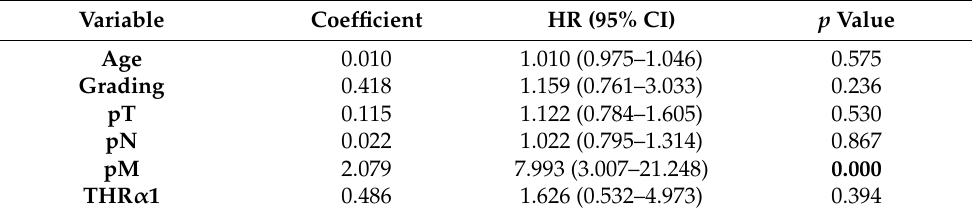
Figure 2. Kaplan–Meier survival analysis among thyroid hormone receptor α 1 (THR α 1) positive and negative patients. DFS of patients with unifocal BC. Table 2. Multivariate Cox regression analysis of unifocal BC patients regarding